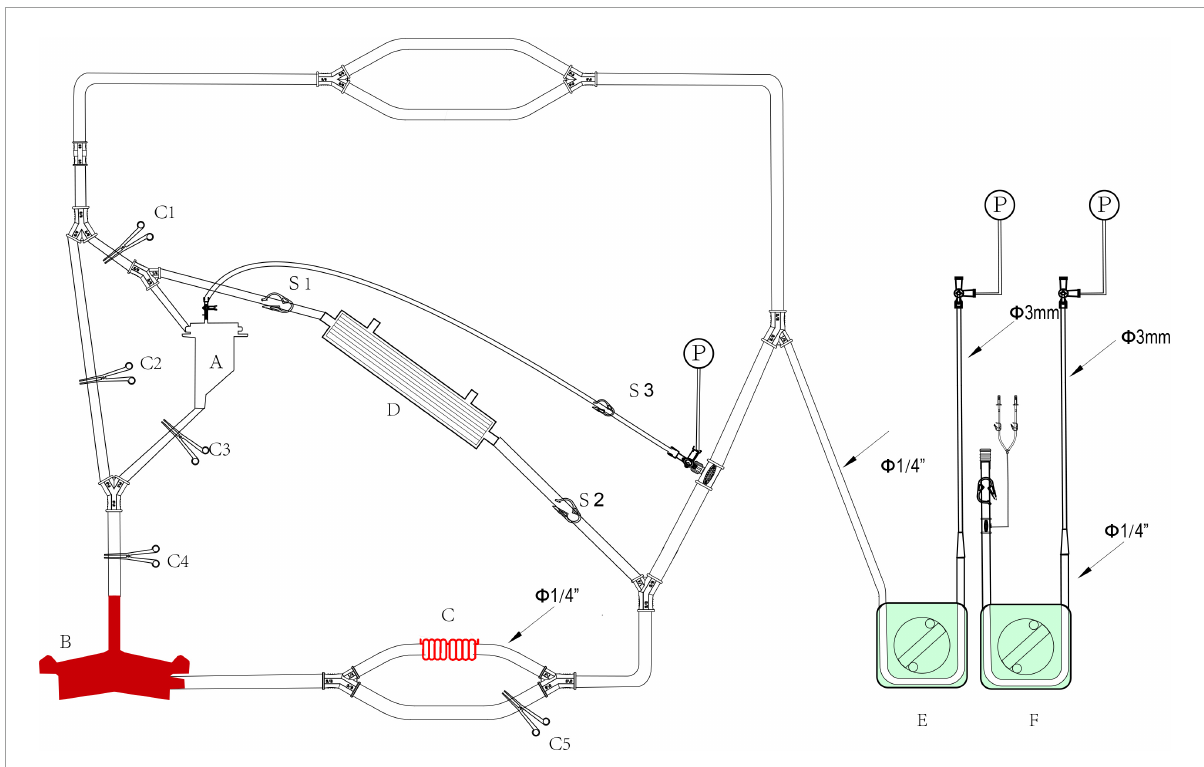
FIGURE4 The assembled LHB circuit for perfusion. A , Hard-shell reservoir for priming and CPB reservation. B , centrifugal pump; C , heat exchanger; D , ultrafilter, E,F , roller pumps. C1-C5 , Tube clumps; S1-S3 , stop-flow clips.